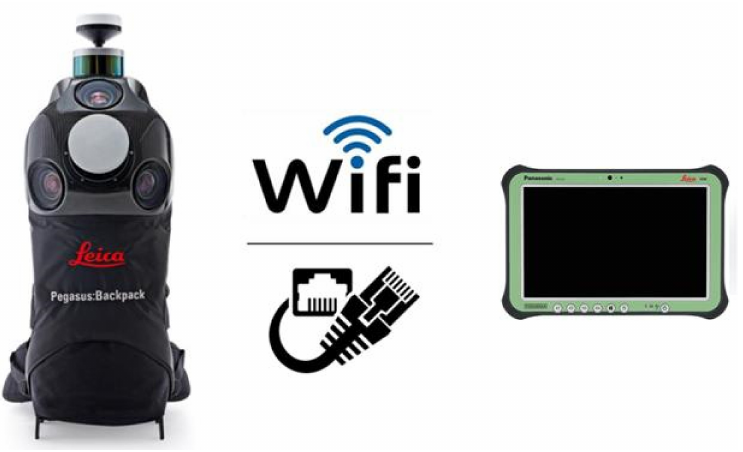
Figure 1. Leica Pegasus equipment (https://leica-geosystems.com/ (accessed on 12 December